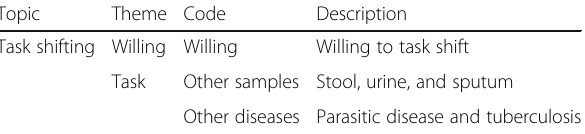
Table 6 Analytical framework of perception of the future (task shifting) Topic Theme